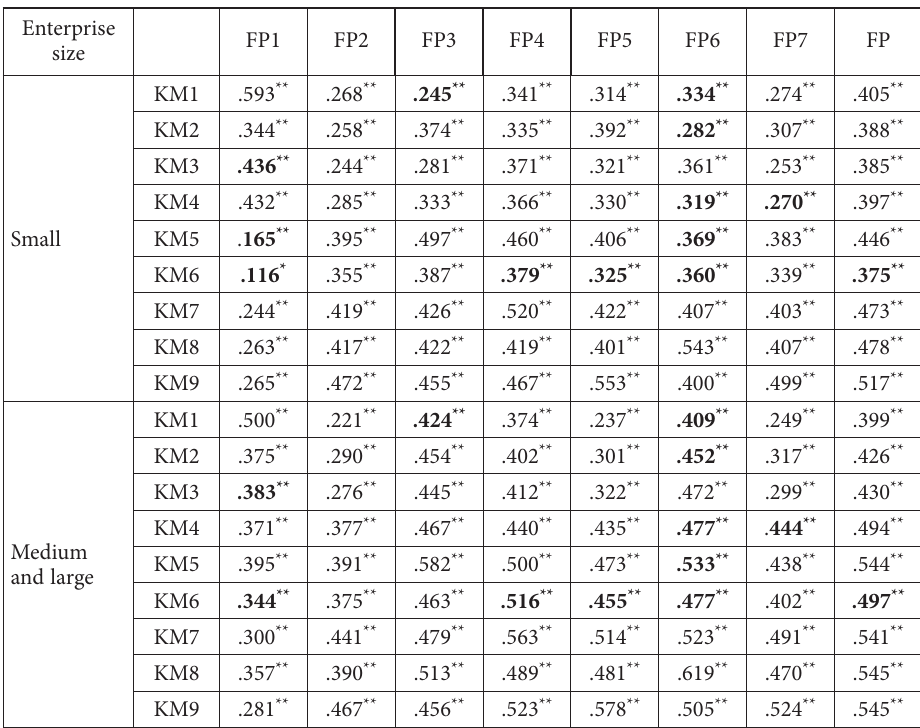
Table 4. Correlation coefficients between the dimensions of knowledge management and the dimen- sions of financial performance (items) and dimensions for small companies and medium and large companies (observed